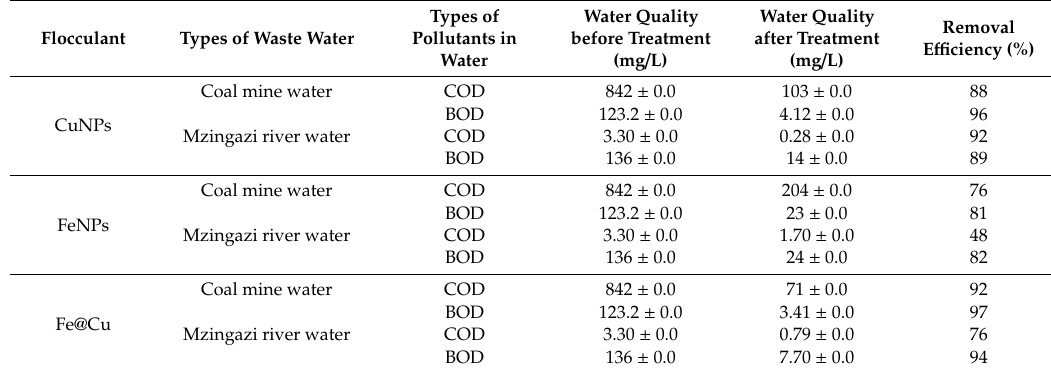
Table 3. Removal e ffi ciency for COD and BOD by nanoparticles (FeNPs, CuNPs and Fe@Cu) from coal mine wastewater and Mzingazi river water at room temperature.